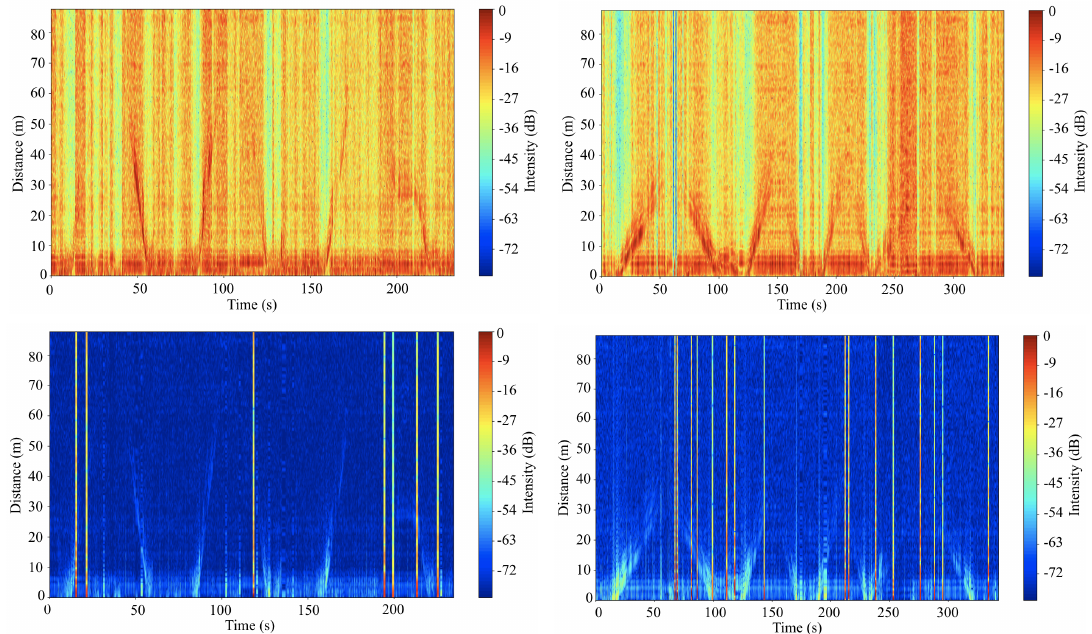
Figure 16. Raw data plot for detection of the car ( top left ) and person ( top right ) and clutter rejected data plot for detection of the car ( down left ) and person ( down right